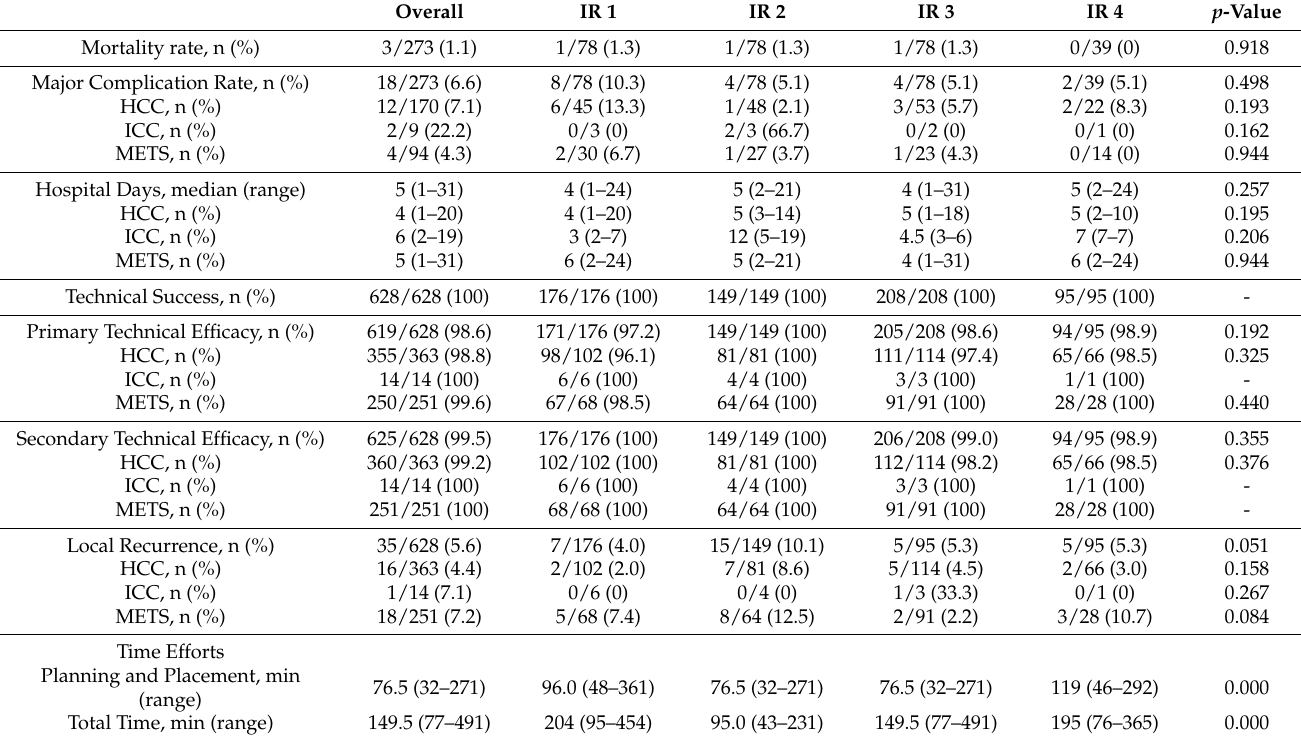
Table 2. Ablation Results grouped by